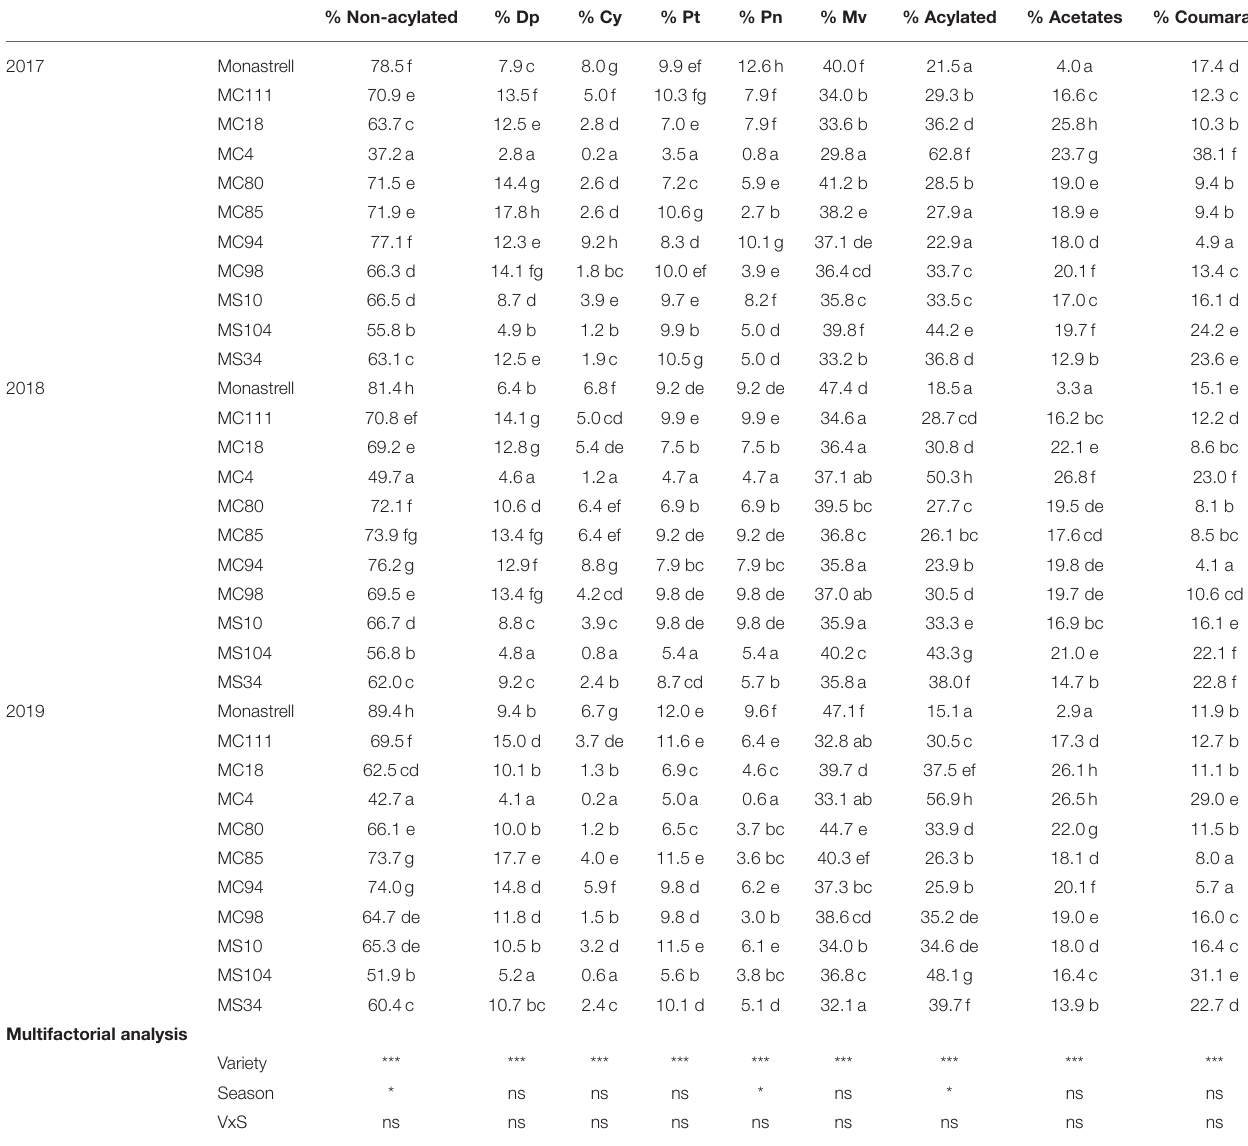
TABLE 3 | Profile of anthocyanins in Monastrell grapes and their hybrids in the trhee seasons (2017–2019). % Non-acylated % Dp % Cy % Pt %